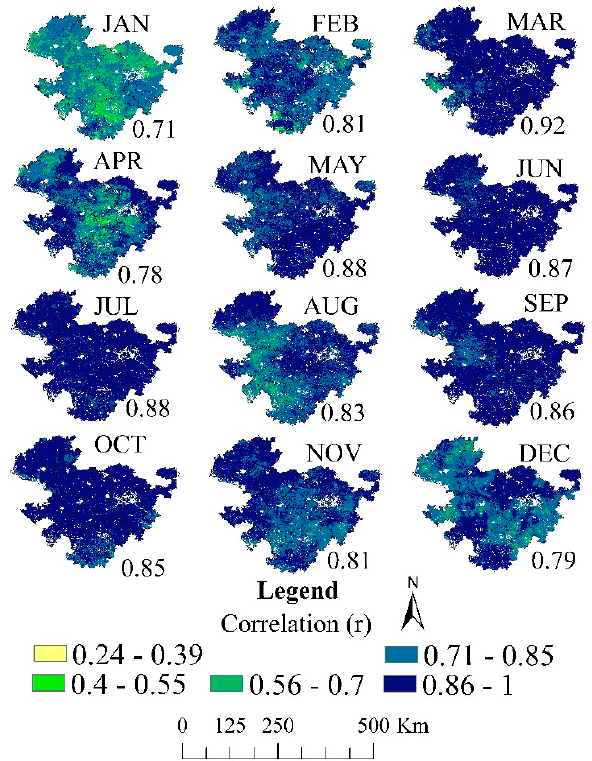
Figure A2: Correlation coefficient values between results of CDI_M, derived from Method-I and Method-II (bottom right values of each month indicates the average correlation coefficient value over the study area).